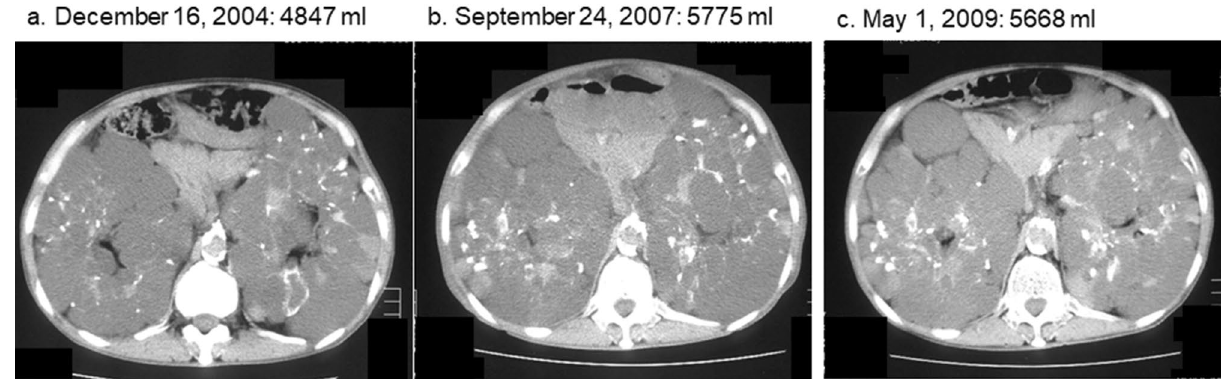
Figure 3. A representative case, abdominal computed tomography images (Case 3). Total kidney volume continued to increase after initiation of hemodialysis [( a ) 4847 ml, December 16, 2004, ( b ) 5775 ml, September, 24 2007]. Cinacalcet administration was started on April 9, 2008. Total kidney volume did not increase during the cinacalcet treatment period [( c ) 5668 ml, May 1, 2009].